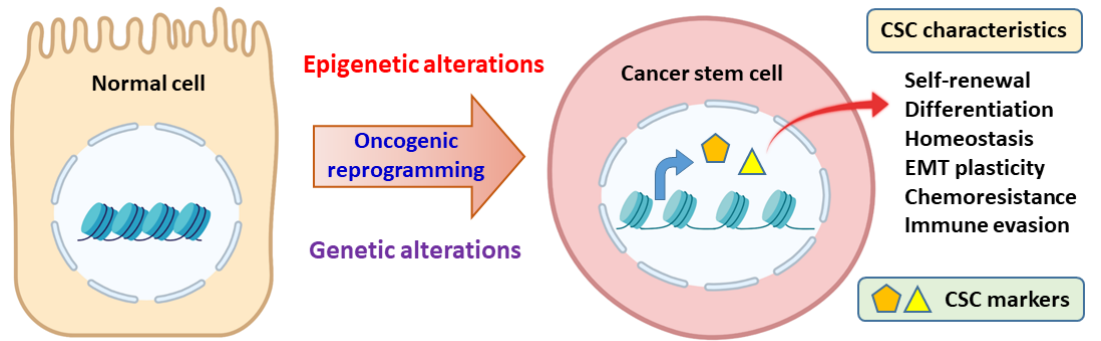
Figure 1. The characteristics of cancer stem cells (CSCs). CSCs can emerge through acquiring genetic and epigenetic alterations that leads to aberrant expressions of CSC markers and allows CSCs to evade immunosurveillance and resist anticancer therapy. EMT, epithelial-mesenchymal transition. Graph created with Biorender.com (accessed on 2 March 2022).